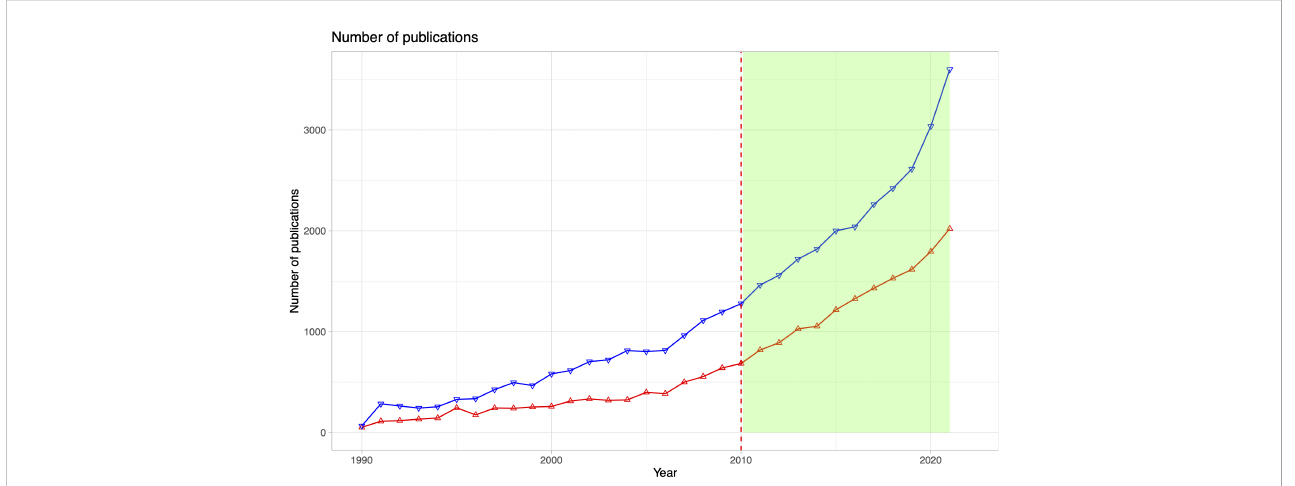
FIGURE 1 The number of publications published after 1990 on Arctic (red crosses) and Antarctic (blue triangles) marine biological and ecological topics. The Web of Science ™ research has been used with the Web of Science Core Collection Database on 23 September 2022. For the Arctic, the following search string was used: “ Arctic AND (Bio* OR Eco*) AND (Marine OR Ocean*) ” and for the Antarctic: “ (Antarctica* OR ‘ Southern Ocean ’ ) AND (Bio* OR Eco*) AND (Marine OR Ocean*) ” . The green highlight shows the time frame (2011-2021) assessed in this paper. The red dashed line symbolises the year of the last publication reported in Wassmann et al.